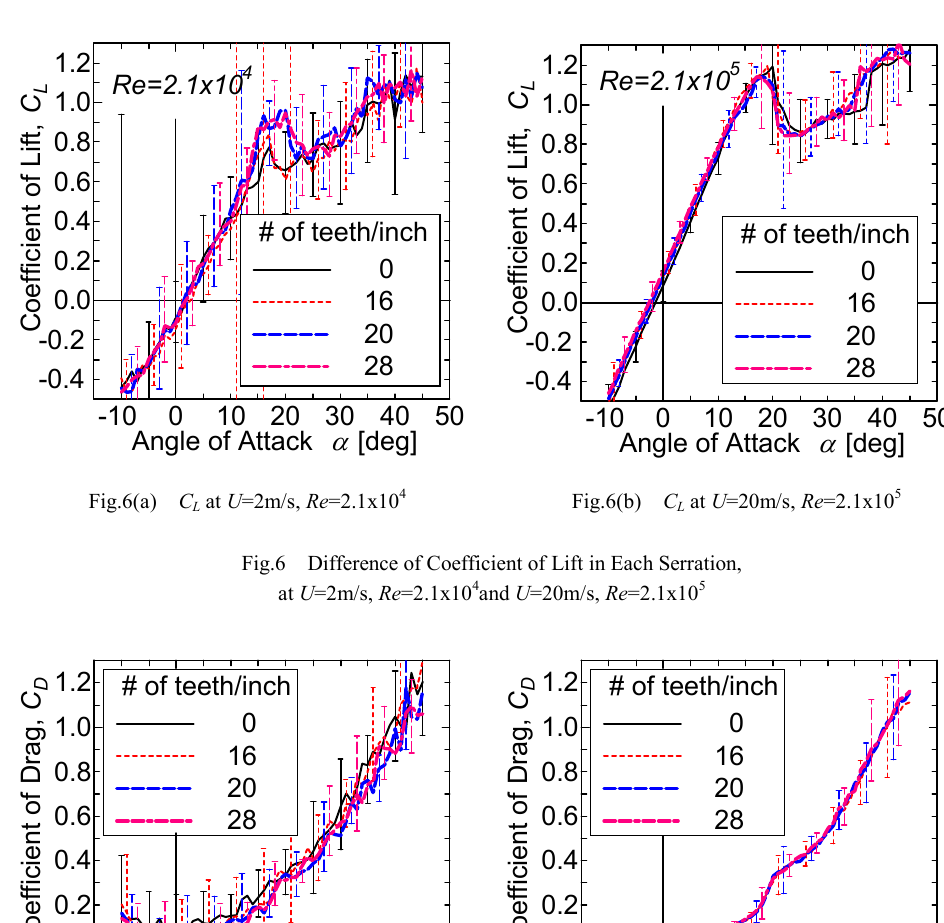
Fig.7 Difference of Coefficient of Drag in Each Serration, at U =2m/s, Re =2.1x10 4 and U =20m/s, Re =2.1x10 5